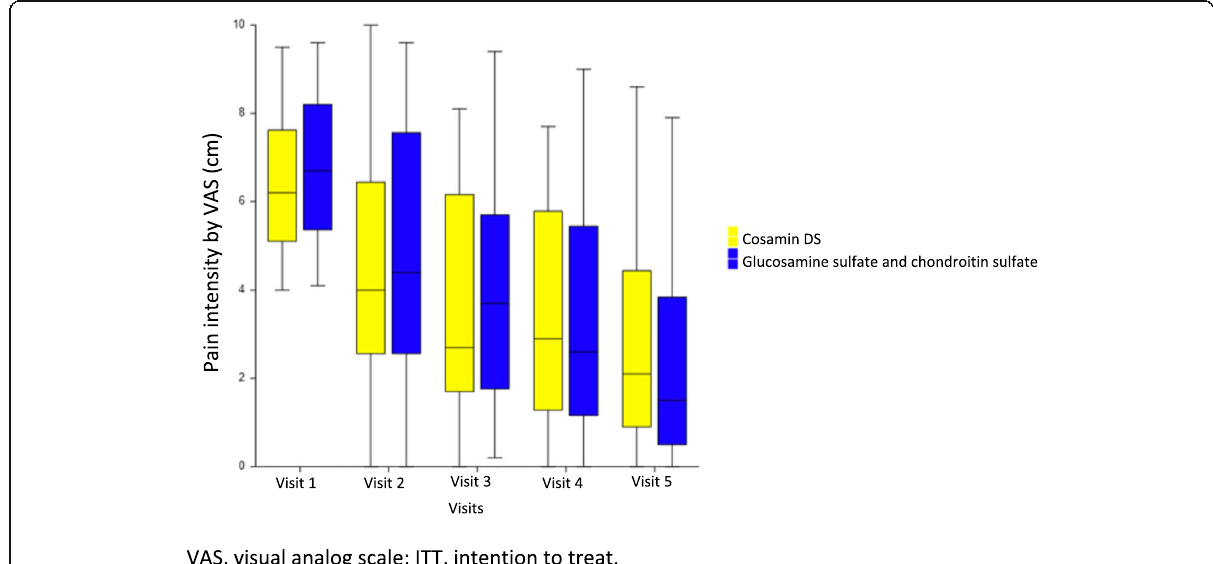
Fig. 3 Evaluation of pain intensity by VAS at each visit in ITT population (N = 89). VAS visual analog scale, ITT intention to